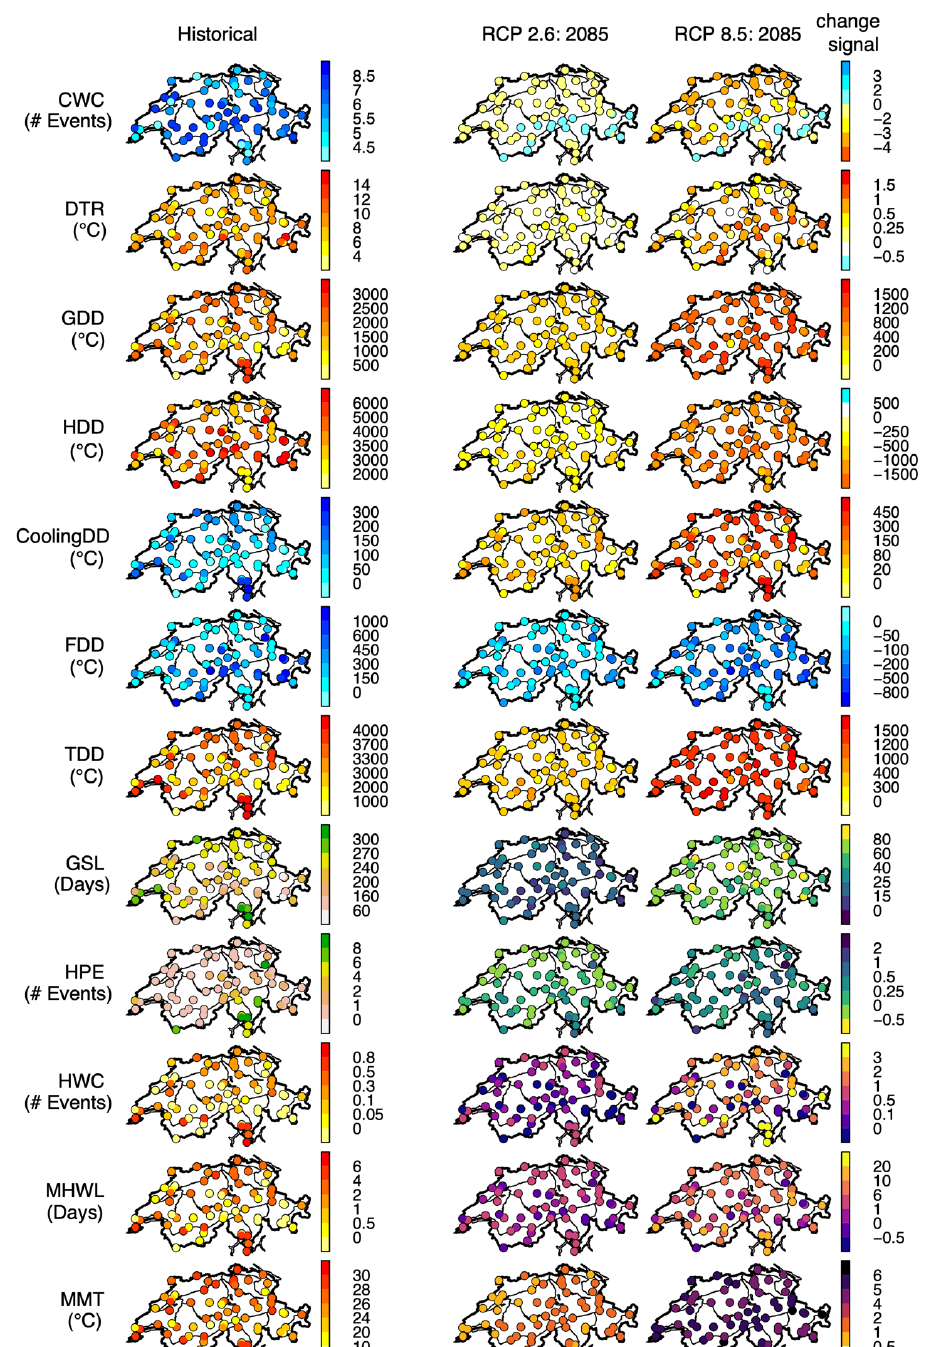
Figure 3. Overview on change signals of class A indices (one index per row). The first column ( left column ) shows the values of the respective index during the historical period as derived from observations. The second and third columns show the median of the change signal between the historical period and the period 2085 for RCP2.6 ( central column ) and RCP8.5 ( right column ). The multi-model median values of the change signal are shown.